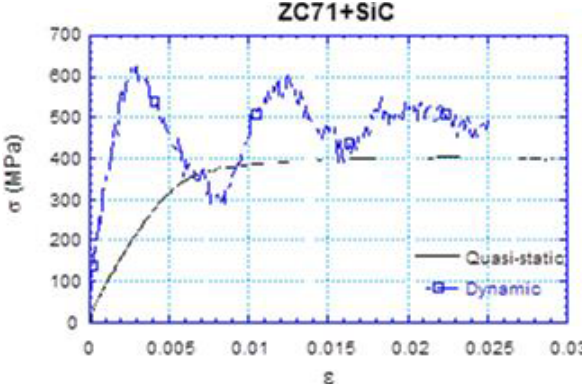
Figure 2. Stress-strain curve pertinent to SiC-reinforced ZC71 magnesium alloy at high strain